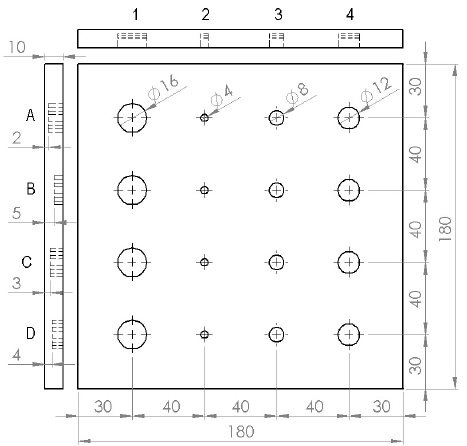
Figure 3. Schematic illustration of austenitic stainless steel (SUS 316) sample along with the geometry and location of artificial flat ‐ bottomed holes representing locally wall thinned areas of different sizes at varying depth levels.